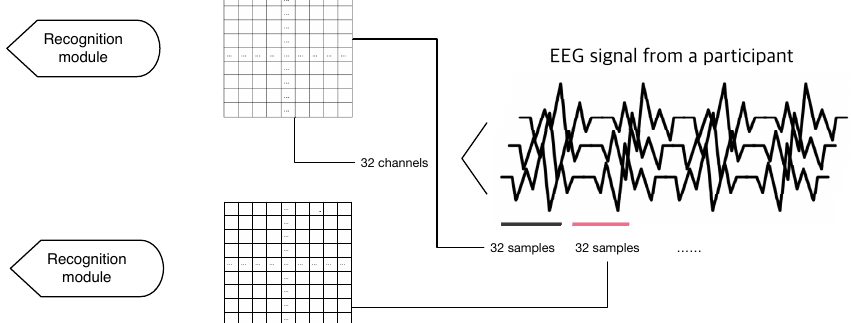
Figure 4. The construction of input data. 32 consecutive samples from 32 EEG channels composite